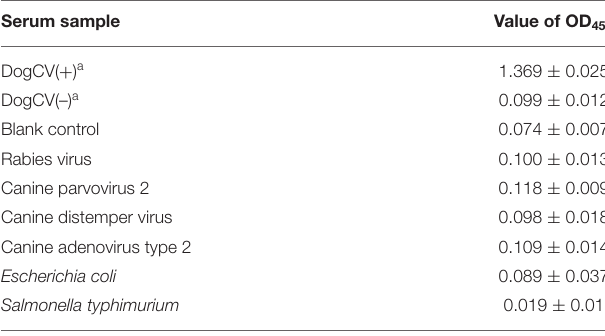
TABLE 2 | Results of cross reaction test of direct ELISA. Serum sample